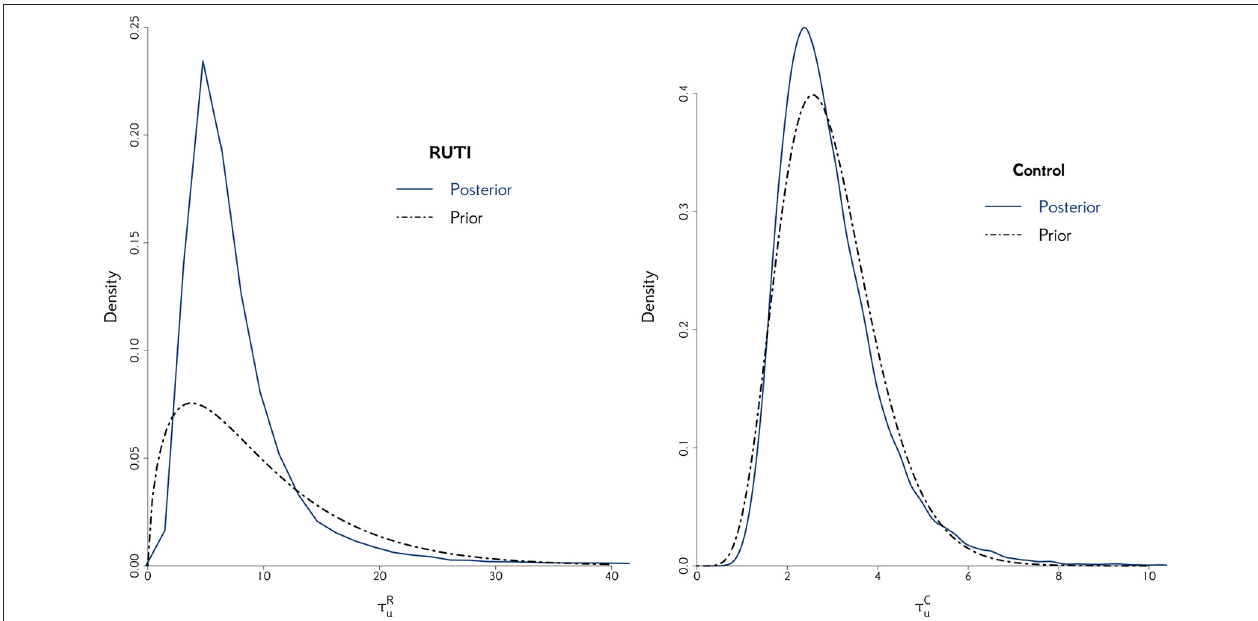
FIGURE 4 | The posterior distribution of the random effect precision is displayed for both RUTI and Control groups, along with their corresponding best gamma distribution fit. In both cases, we elicit the prior distribution for τ u